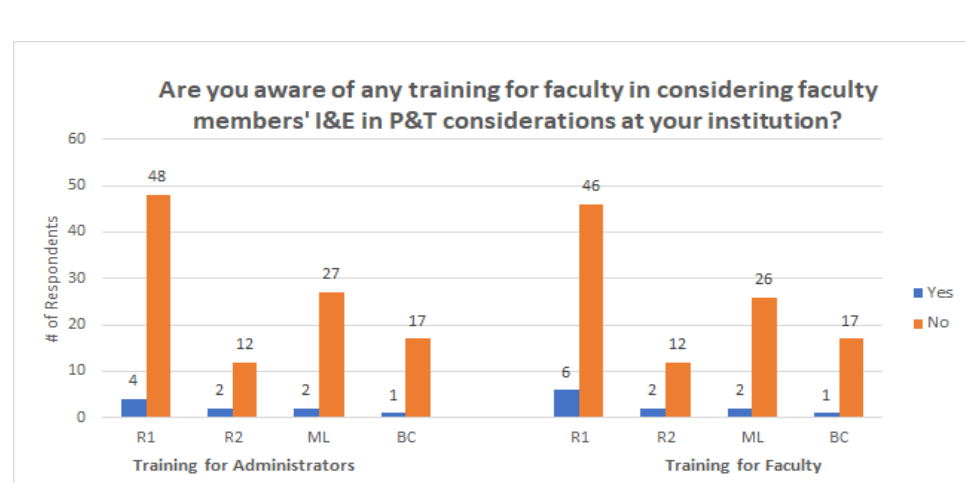
Figure 15. Comparison of institution type responses of the awareness of any training for administra-